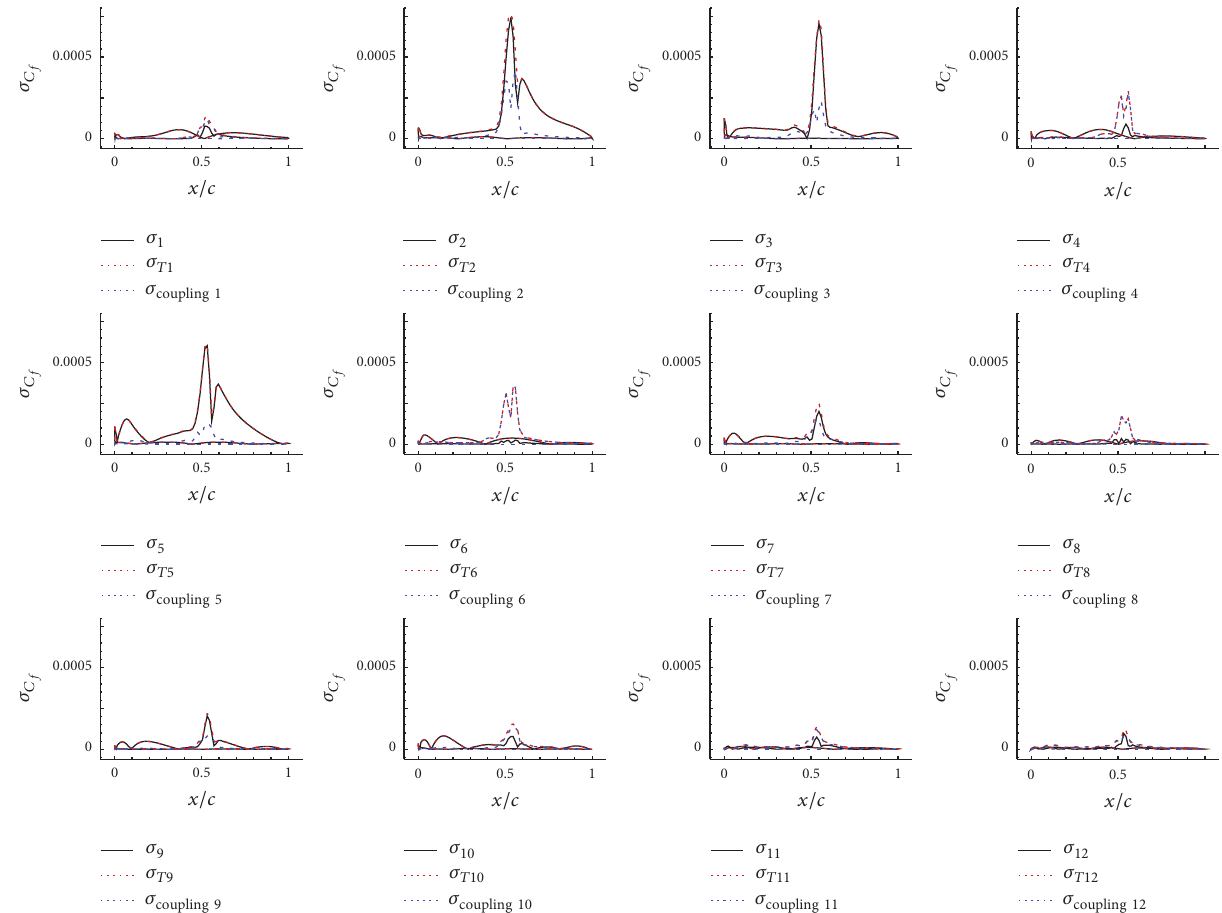
Figure 13: The results of 𝐶 𝑓 distribution by Sobol’s analysis ( 𝜎 𝑖 is the partial standard variation with uncertain variable 𝑖 ; 𝜎 𝑇𝑖 is the total partial standard variation with uncertain variable 𝑖 ; 𝜎